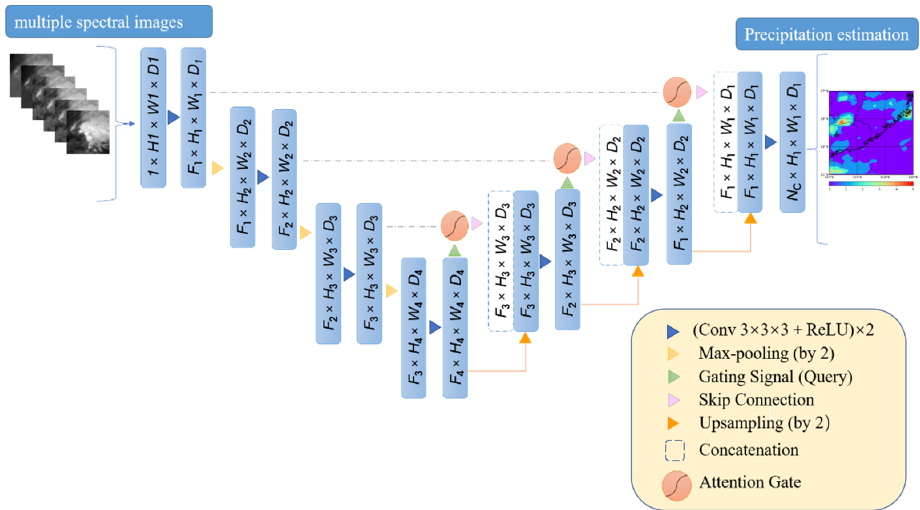
Figure 1. Visualized structure of Attention-Unet network.